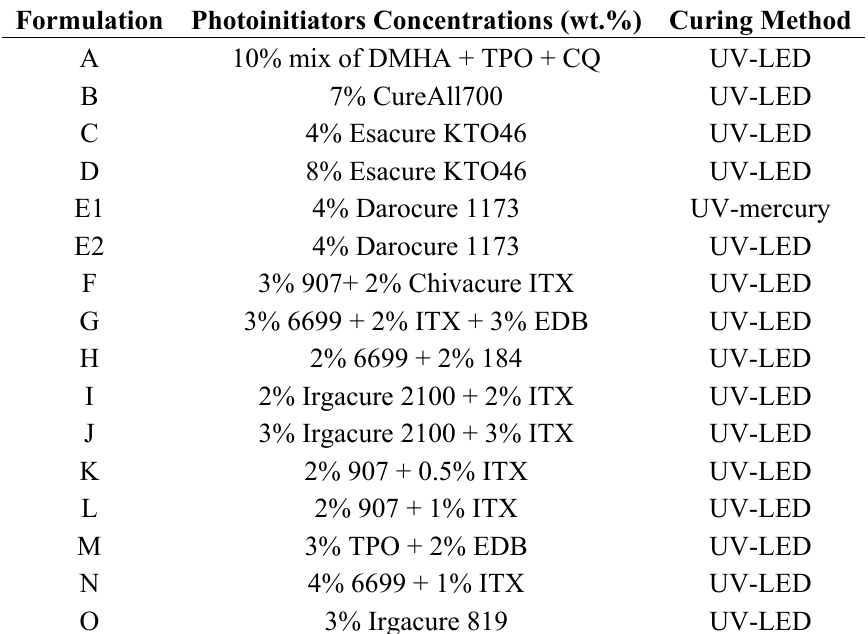
Table 2. Photoinitiators concentrations (in wt.%) for each formulation and the curing method used. Formulation